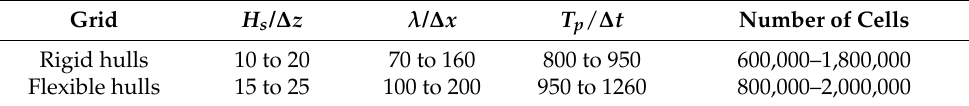
Table 2. Discretization